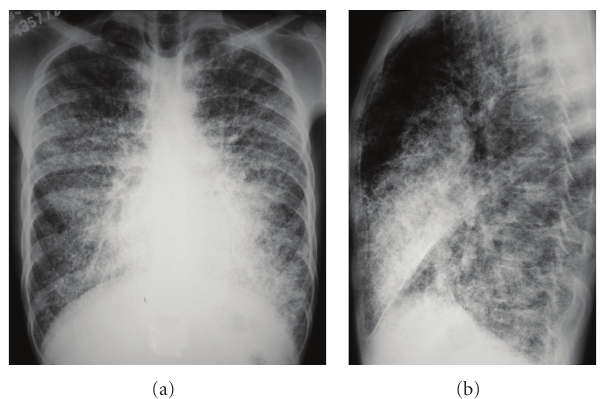
Figure 1: Chest radiographs in anteroposterior (a) and lateral (b) incidences shows a di ff use symmetric lung lesion with confluence of dense micronodular infiltrate. Note the, predominance of the lesions in the paracardiac regions of the lungs.